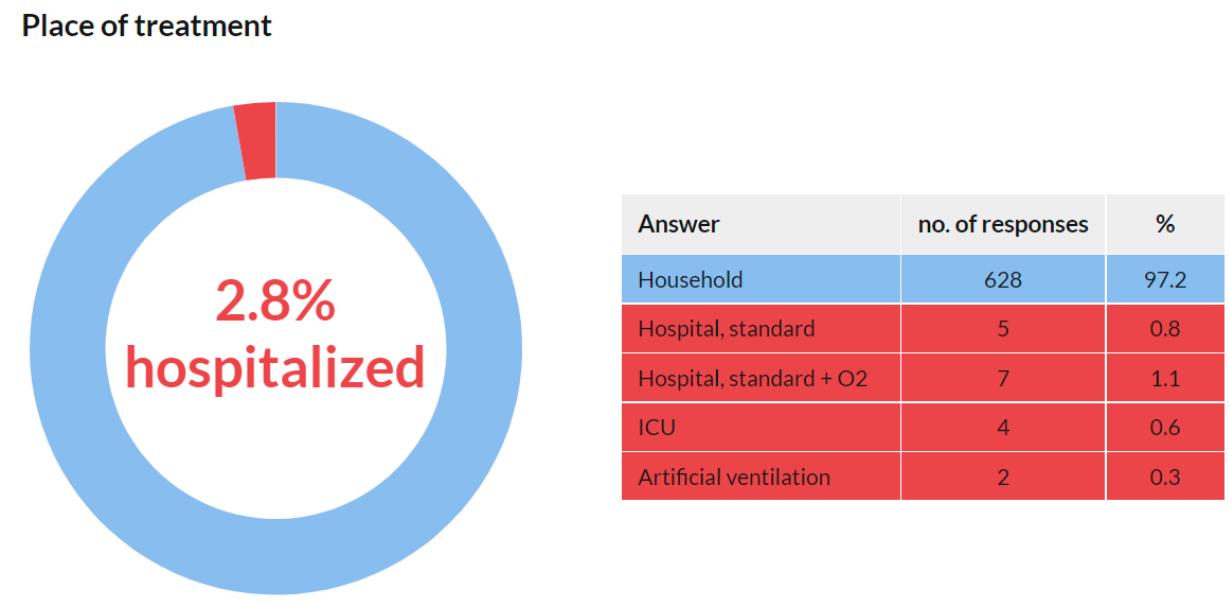
Figure 10. Place of treatment.